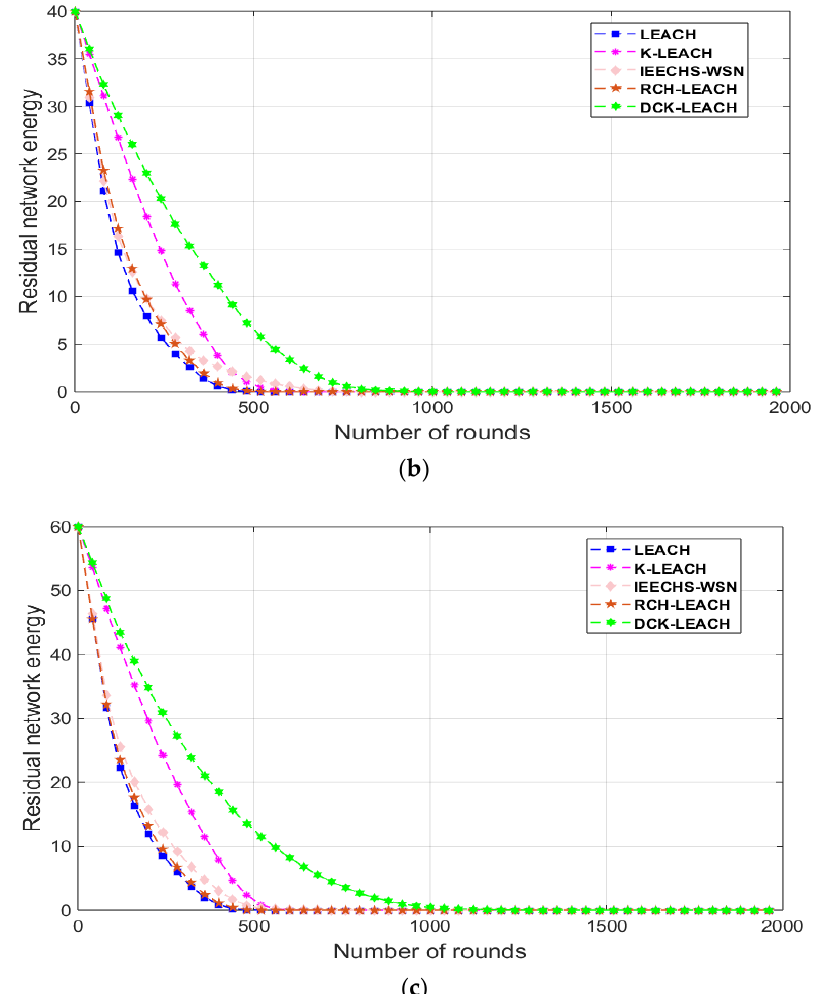
Figure 6. Comparison residual energy of the network in three scenarios: ( a ) 100 nodes, ( b ) 200 nodes, ( c ) 300 nodes.